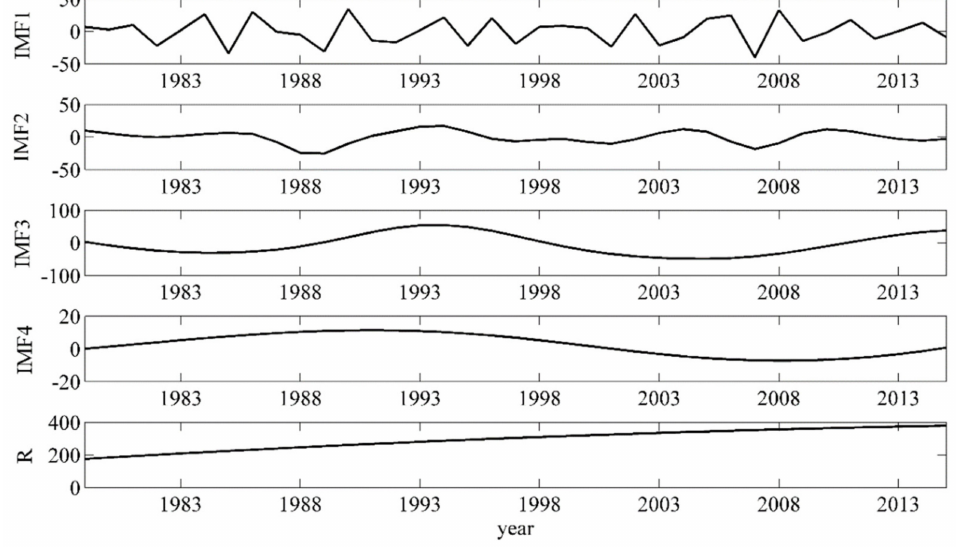
Figure 3. The temporal changes in maize yield during 1979 − 2015 at different timescales based on the EEMD method. Table 1. Average periods and their respective variance contributions of maize yield changes at different timescales in Heilongjiang Province,